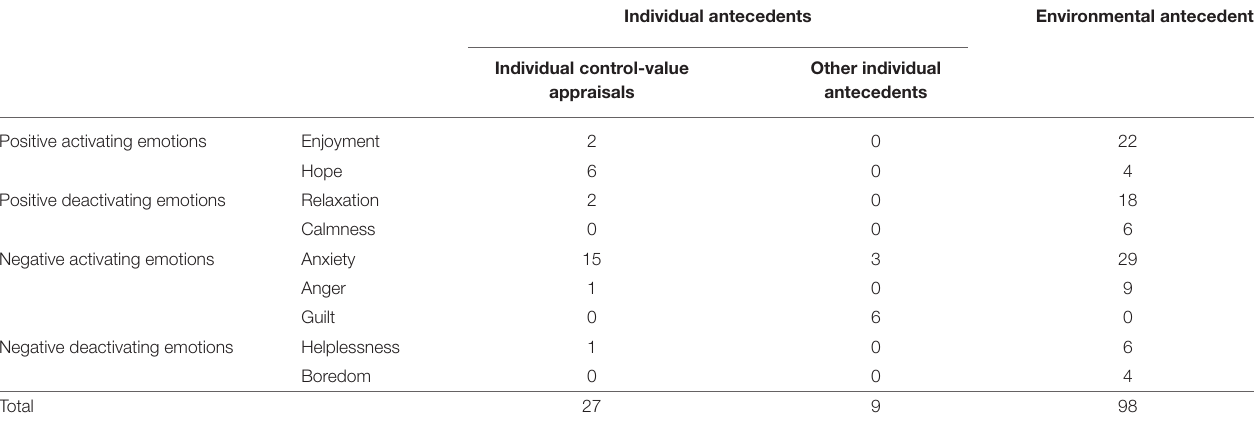
TABLE 6 | The antecedents of emotions experienced in the online learning context.